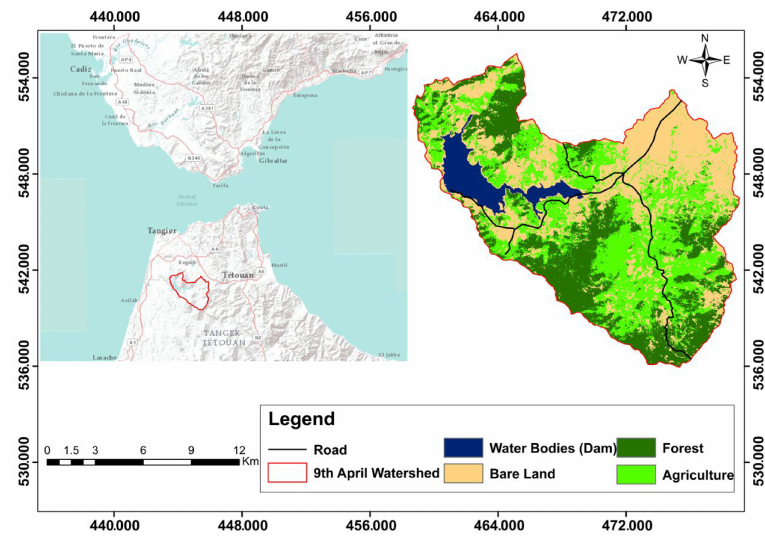
Figure 1. Geographic location of 9th April Watershed, Northern